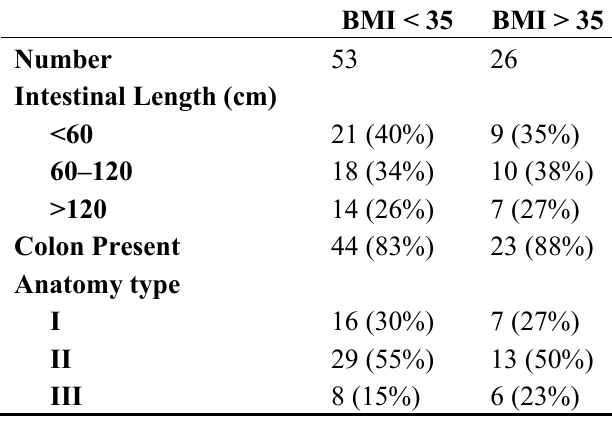
Table 2. Comparison of intestinal anatomy.